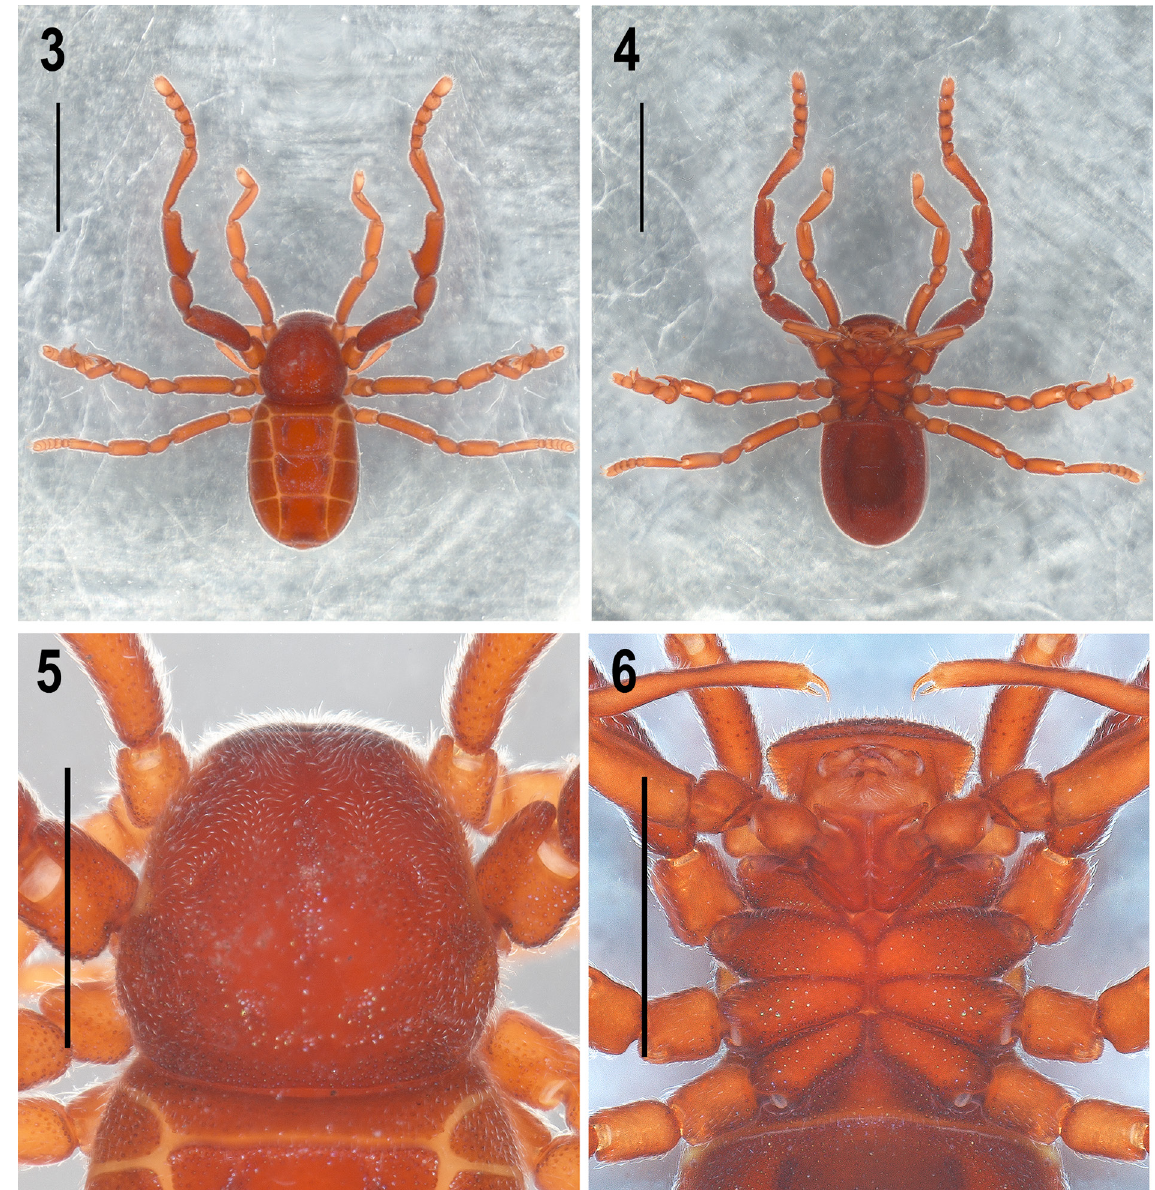
Figs 3–6. Pseudocellus giribeti sp. nov. Holotype, ♂ (MCZ 80010). 3–4 . Habitus, dorsal and ventral views. 5 . Carapace, dorsal view. 6 . Prosoma, ventral view, showing coxosternal region. Scale bars: 3–4 = 2 mm; 5–6 = 0.5